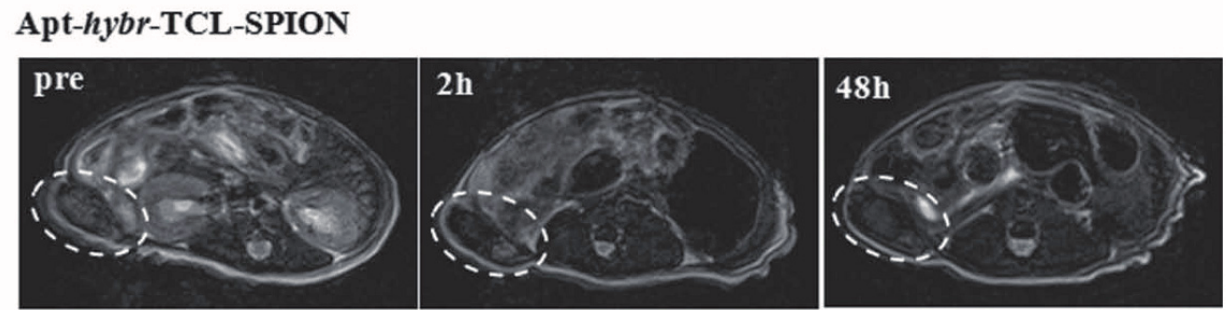
Figure 3. T2-weighted fast spin echo images at the level of the LNCaP tumor on the right side of the mouse taken at 0, 2, 24, 48 h after injection of Apt-hybr-TCL-SPIONs. Reprinted from [118] with permission from John Wiley and Sons, copyright